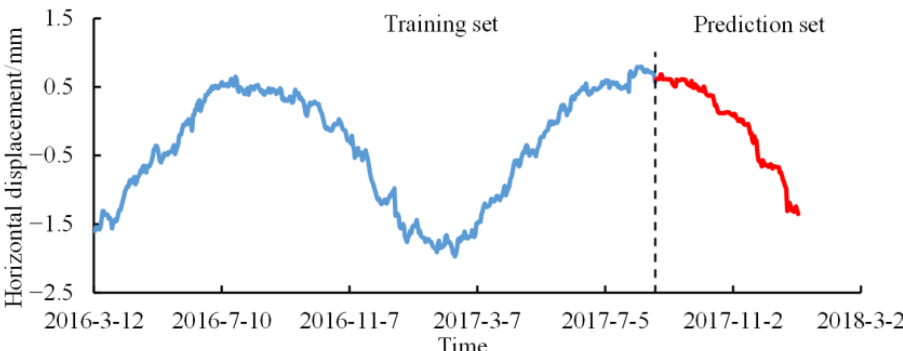
Figure 10. Process diagram of corrected horizontal displacement of the measuring point EX19.